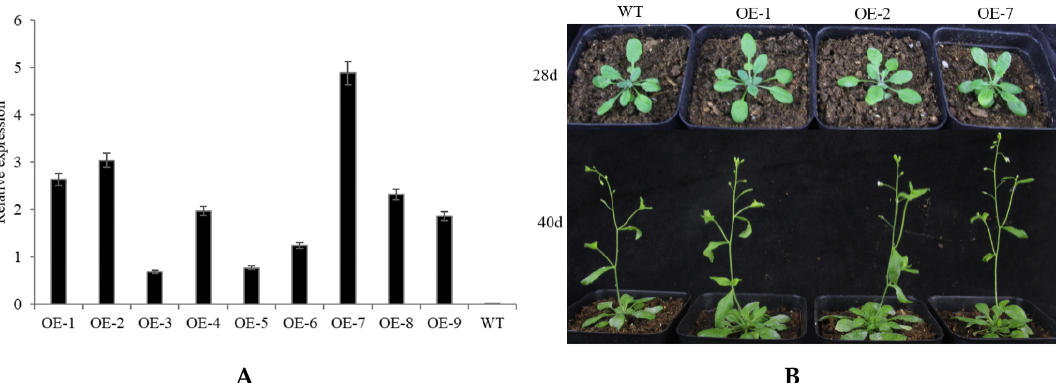
Figure 4. Phenotype observation of CpNAC68 in transgenic Arabidopsis. ( A ). qRT-PCR identification of CpNAC68 transcript levels in the leaves of nine overexpressed Arabidopsis lines and WT plants. AtActin was used as the internal reference gene; bars indicate the SE of the mean from three technical replicates and three biological replicates. ( B ) Phenotype observation of different transgenic lines and WT plants were at different developmental stages. Twelve individual plants for each line were used for height measurements (Figure S1). Bars correspond to standard error.